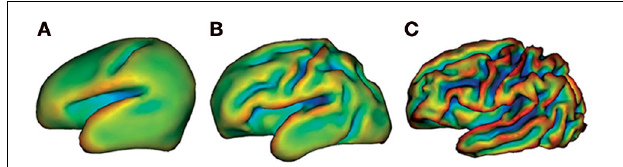
networks have been consistently reported in adults. Reproduced with permission from Elsevier (Van den Heuvel and Hulshoff Pol,